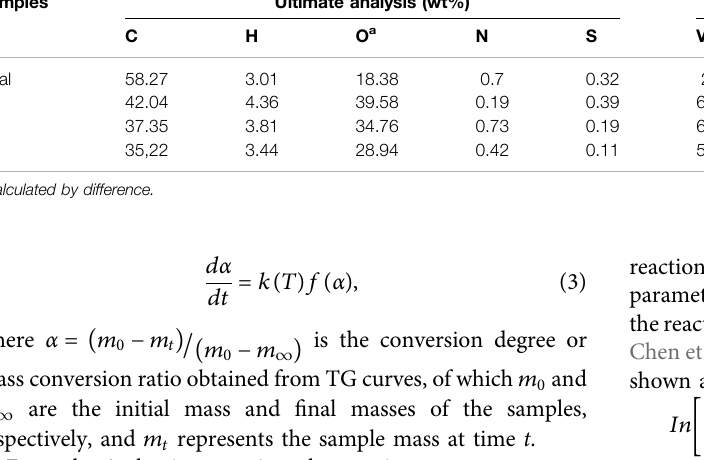
TABLE 1 | Proximate and ultimate analyses of samples on an air-dry basis.